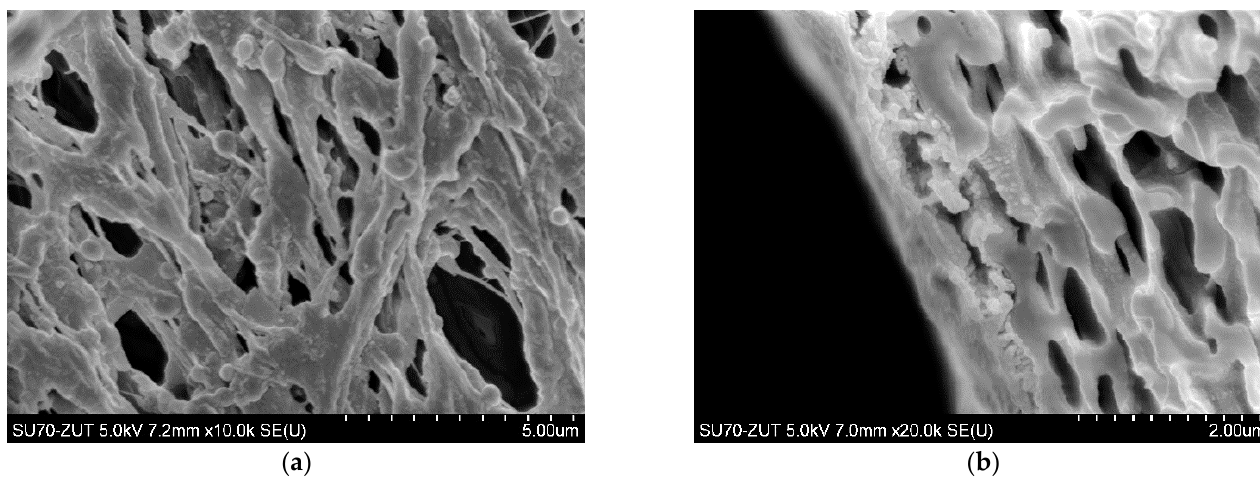
Figure 21. SEM images of PP membranes after cyclic chemical rinsing. ( a ) membrane surface, ( b ) membrane cross-section